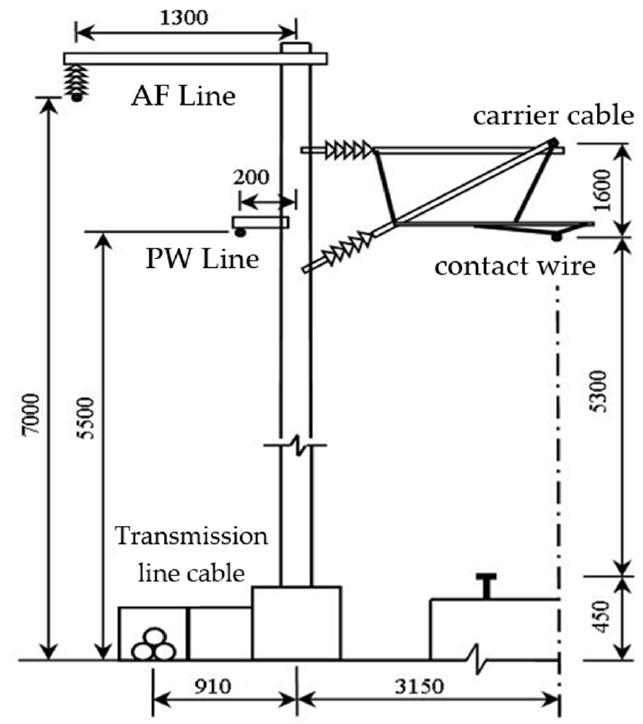
Figure 3. Traction network and cable location in subgrade.